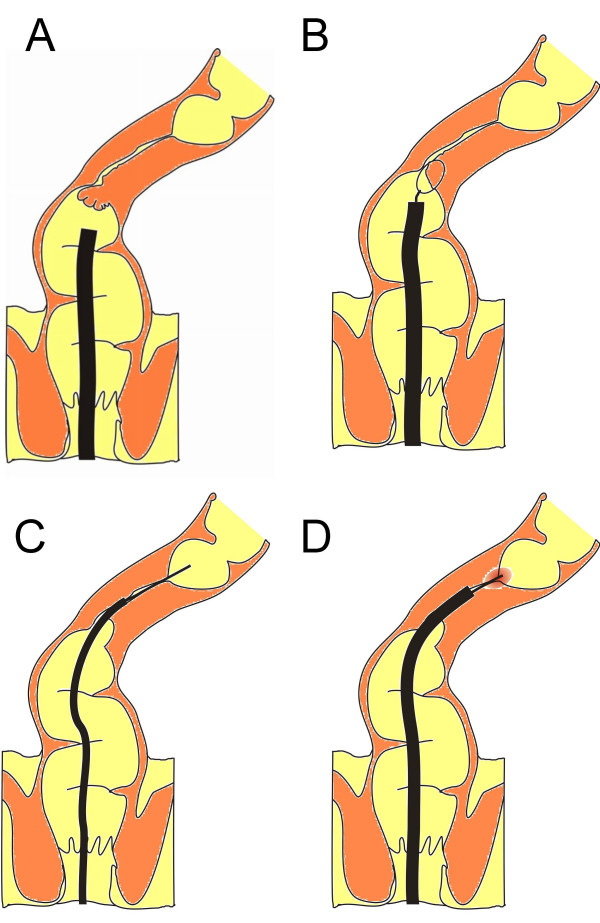
Schematic presentation of first-step endoscopic tumor debulking. A tumorous obstruction of the distal sigmoid colon that cannot be passed with the colonoscope. Polypoid parts of the tumor are removed with the snare (B), and after replacing the colonoscope by a baby endoscope, first a soft wire and then, guided by the wire, the baby gastroscope is pushed through the stenosis (C), the scope is withdrawn, leaving the wire in place, an ERCP catheter is pushed over the wire to stabilize it, and finally a conventional gastroscope that has a working channel wide enough to use a APC probe is pushed beyond the stenosis via the ERCP catheter and the wire. Thereby, APC ablation of the tumor may be performed from the proximal part creating a channel through the tumor (D).